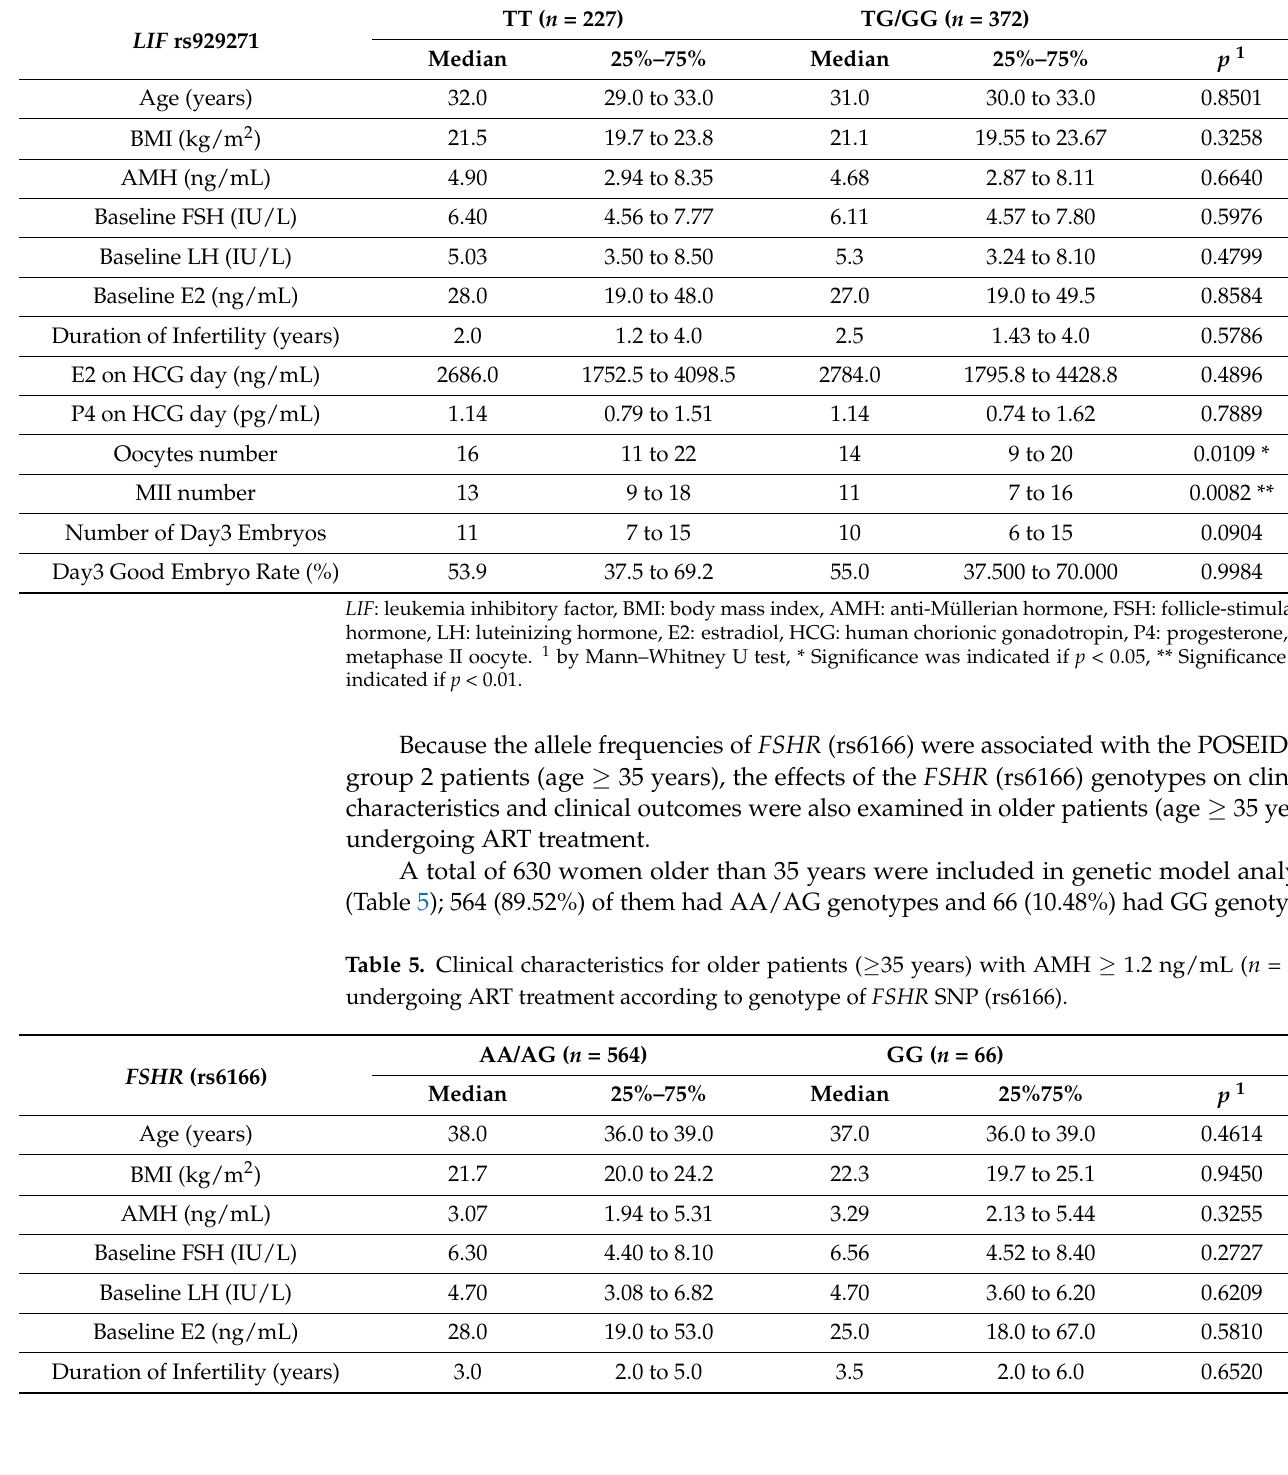
Table 4. Clinical characteristics for younger patients (<35 years) with AMH ≥ 1.2 ng/mL ( n = 599) undergoing ART treatment according to genotype of LIF SNP rs929271.